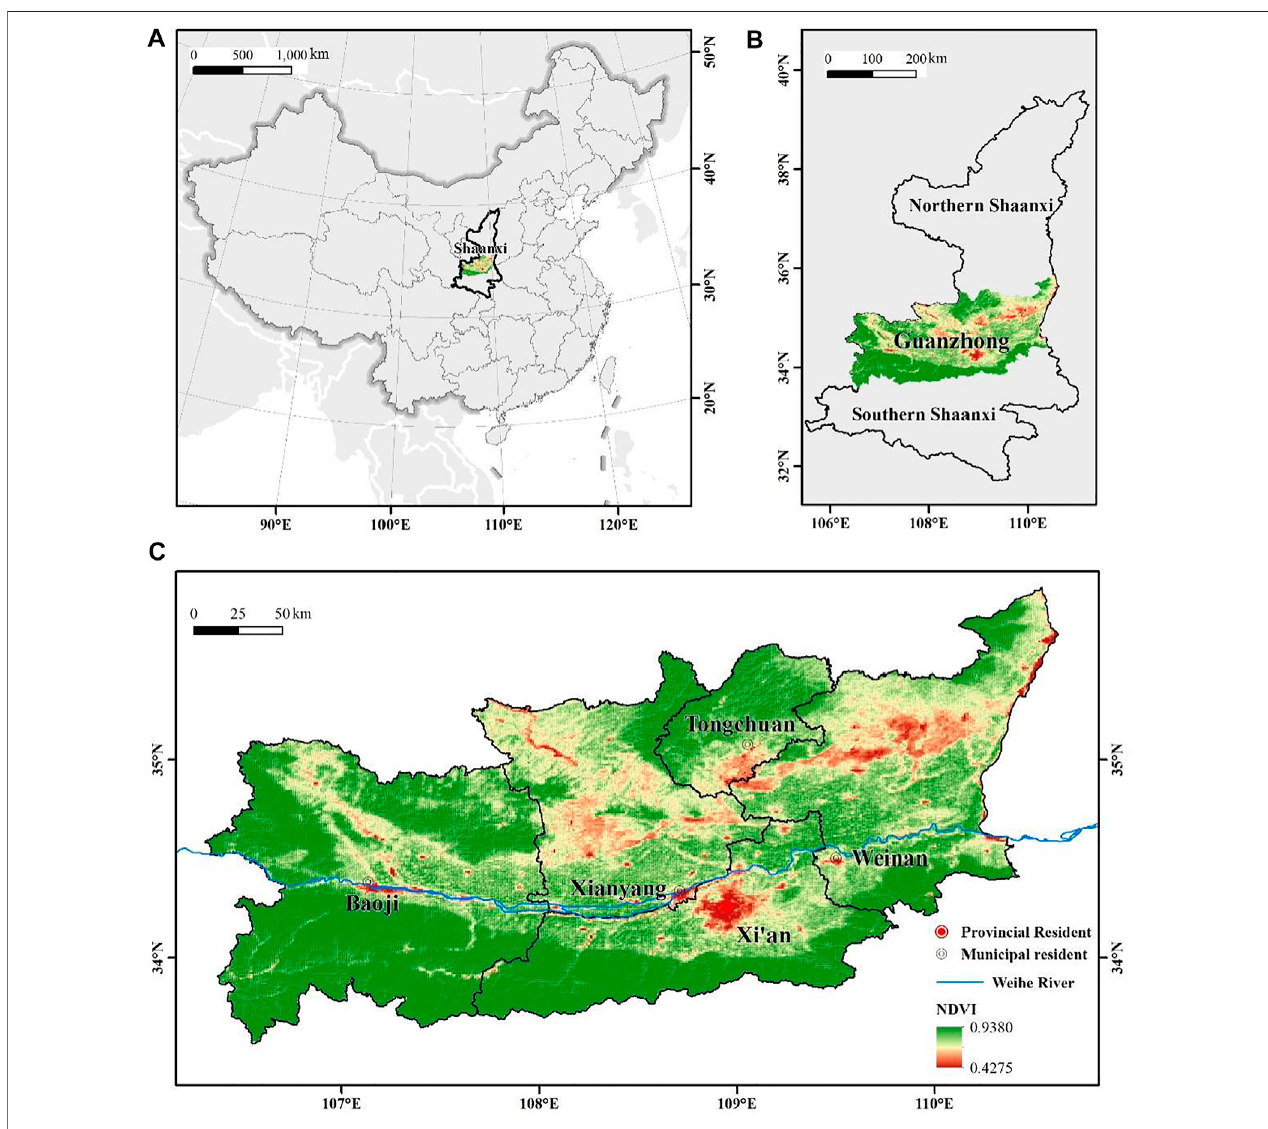
FIGURE 1 | Maps of Guanzhong, Central China. (A) the position of Shaanxi Province in Mainland China, (B) the position of Guanzhong in Shaanxi Province, (C) a map of Guanzhong showing the spatial distribution of the Normalized Difference Vegetation Index (NDVI).